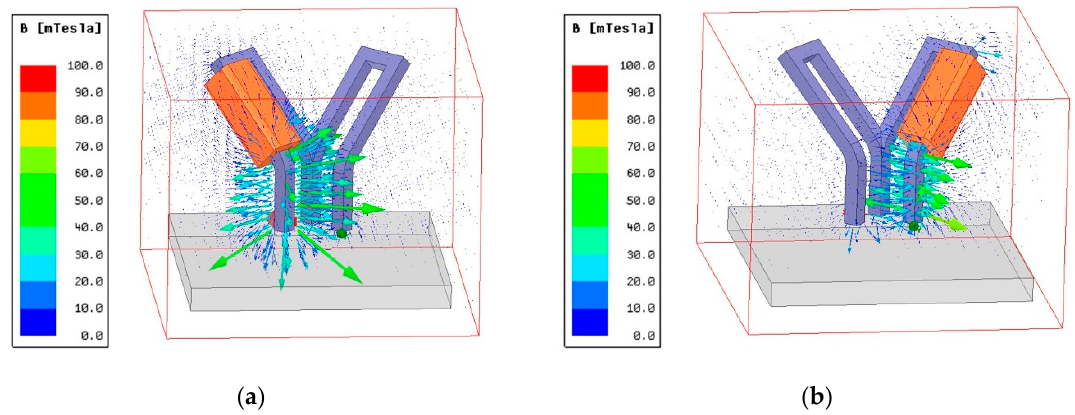
Figure 7. Three-dimensional magnetic field intensity when ( a ) coil 1 and ( b ) coil 2 are energized.